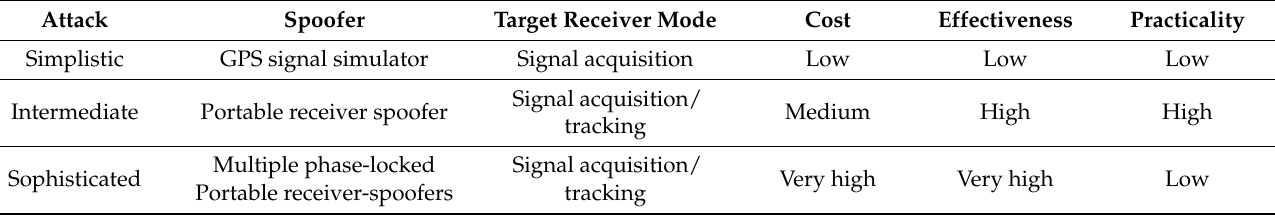
Table 2. Classification of GPS spoofing